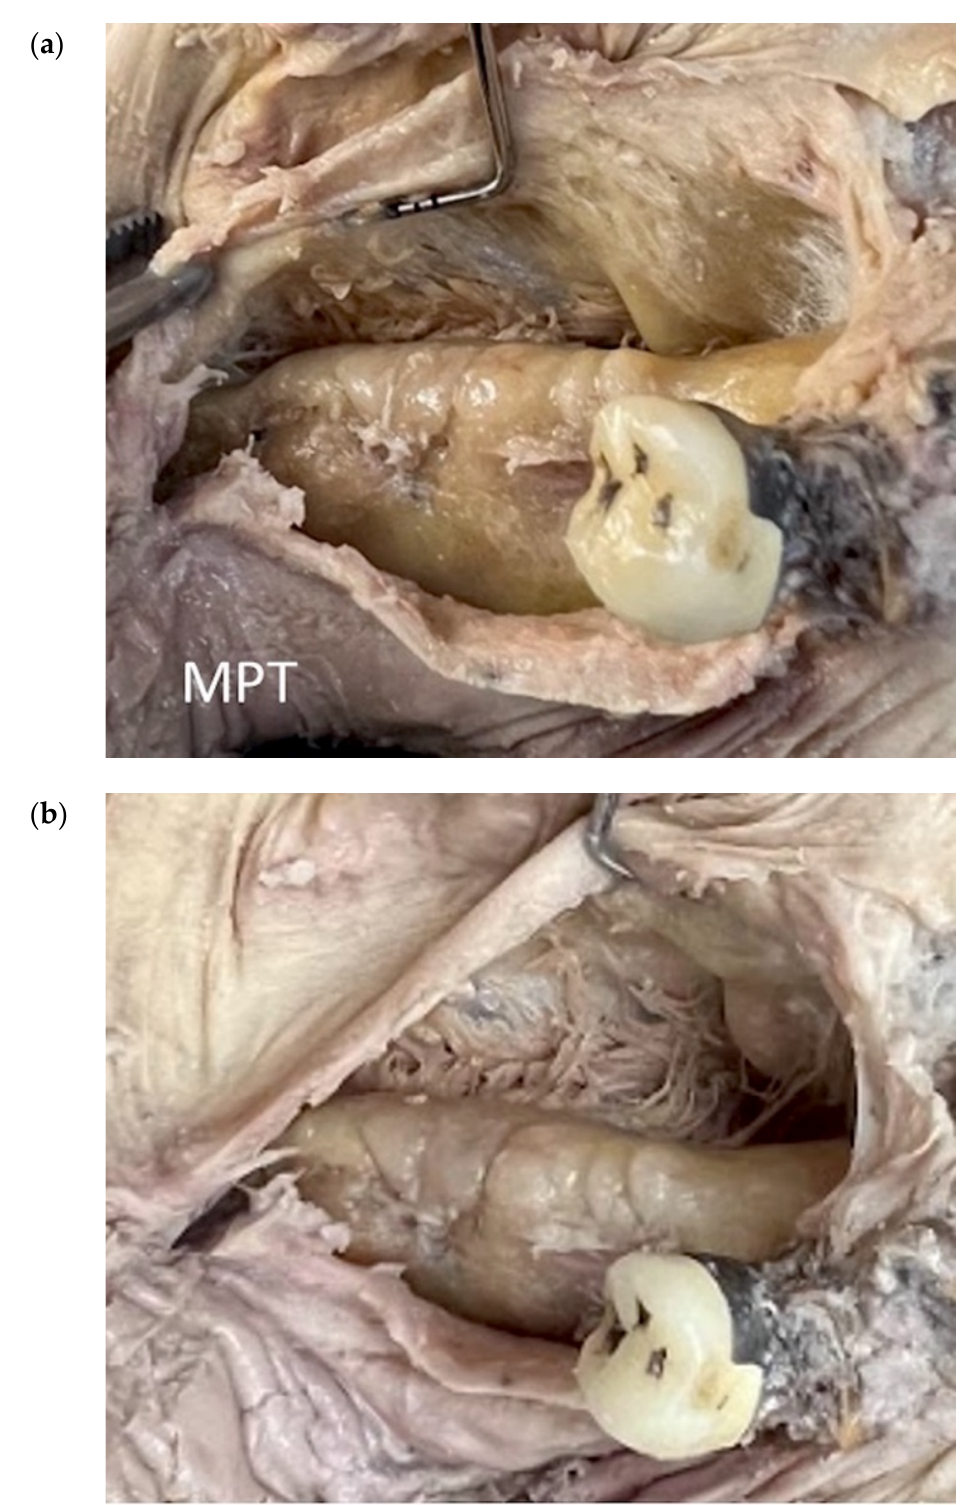
Figure 12. MMR using the MPT technique in a human cadaver model. ( a ) The soft tissue superior to the muscle insertion is pushed in a lingual direction (zone II). ( b ) In the anterior section of the lingual flap, a semi-blunt periosteal release is performed in a sweeping motion with a 15c blade (zone III).